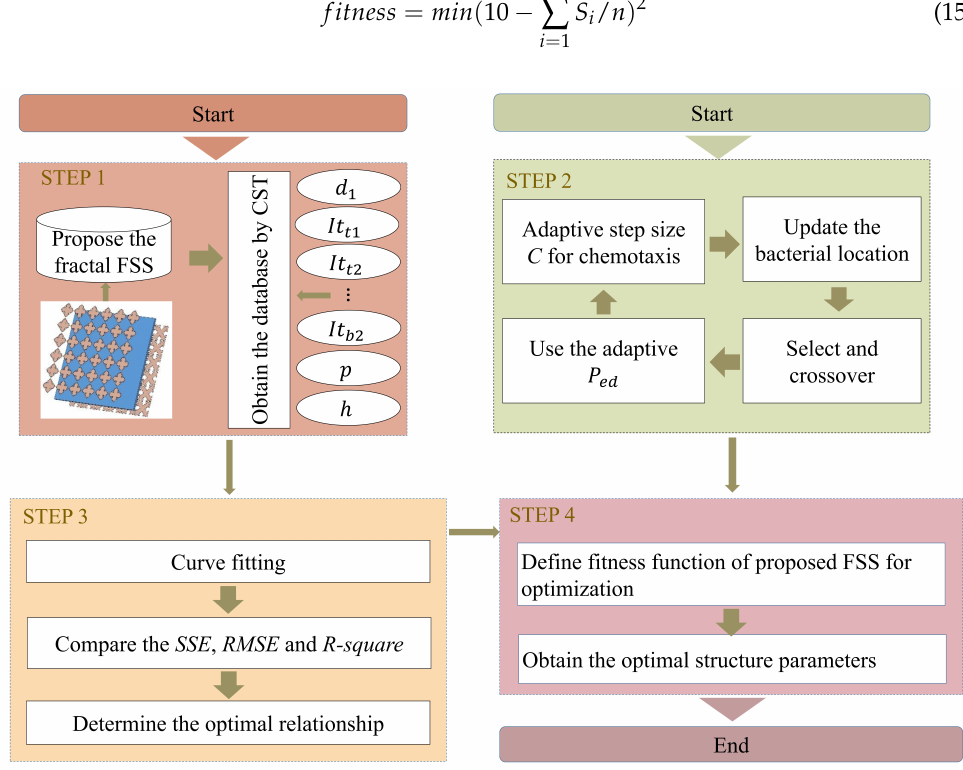
Figure 5. Flowchart for the proposed